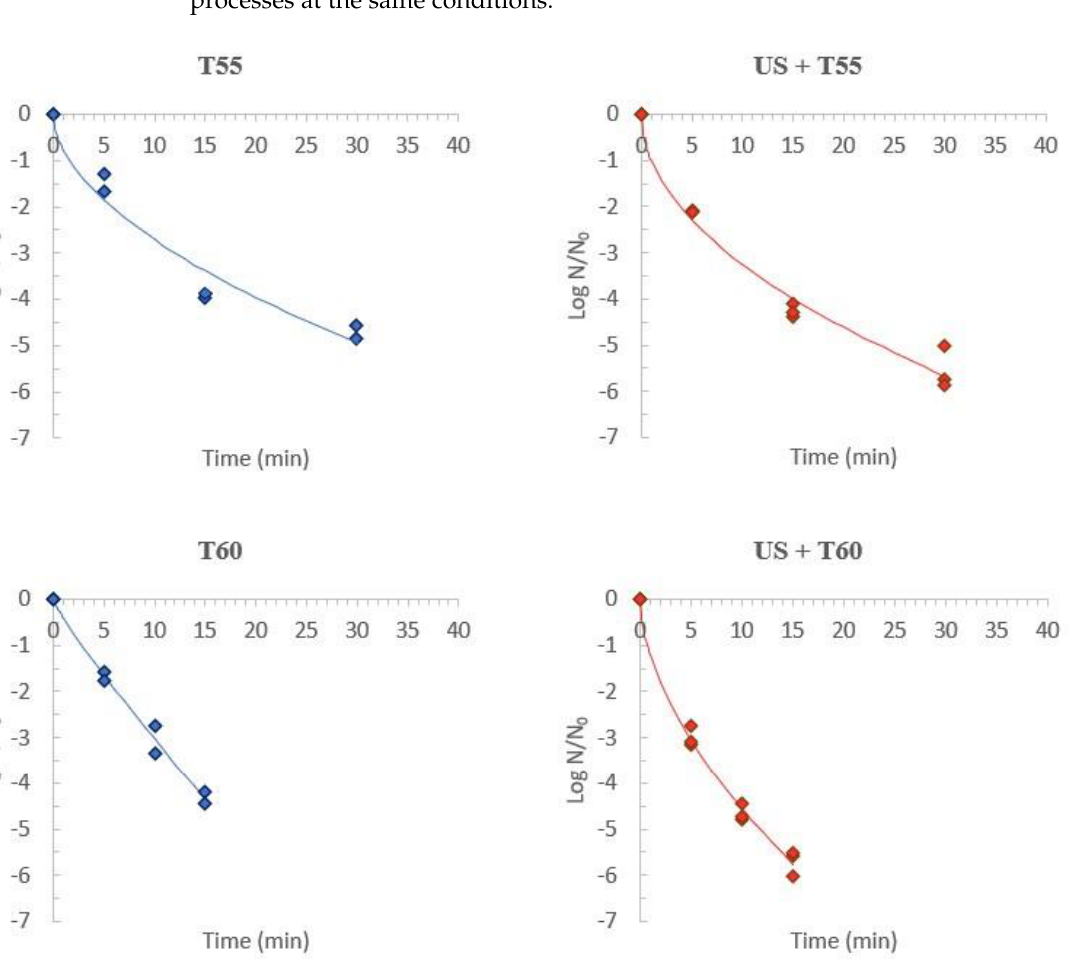
Figure 5. L. innocua survival in kiwi peel treated with thermal and thermosonication processes. Points correspond to the experimental data and lines represent fits of the Weibull model.